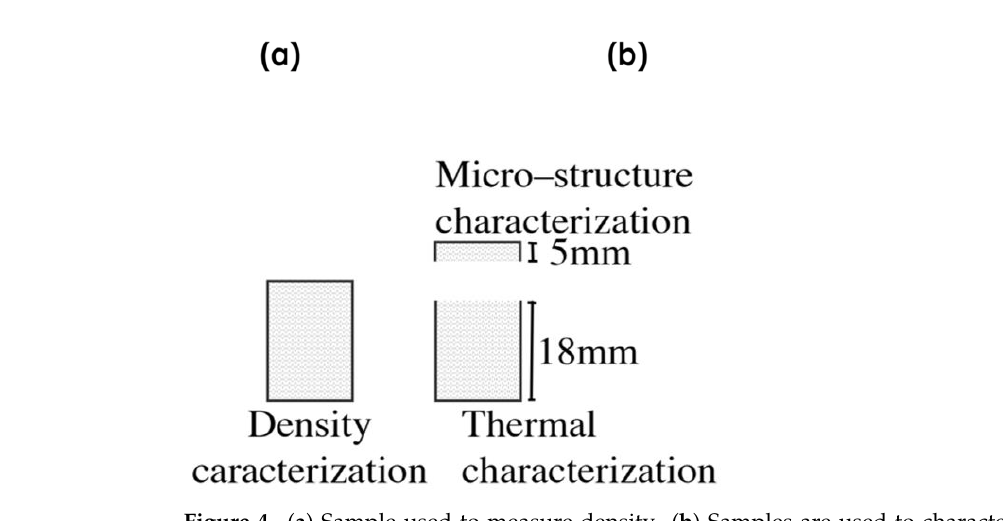
Figure 4. ( a ) Sample used to measure density. ( b ) Samples are used to characterize the cellular structure and thermal conductivity.